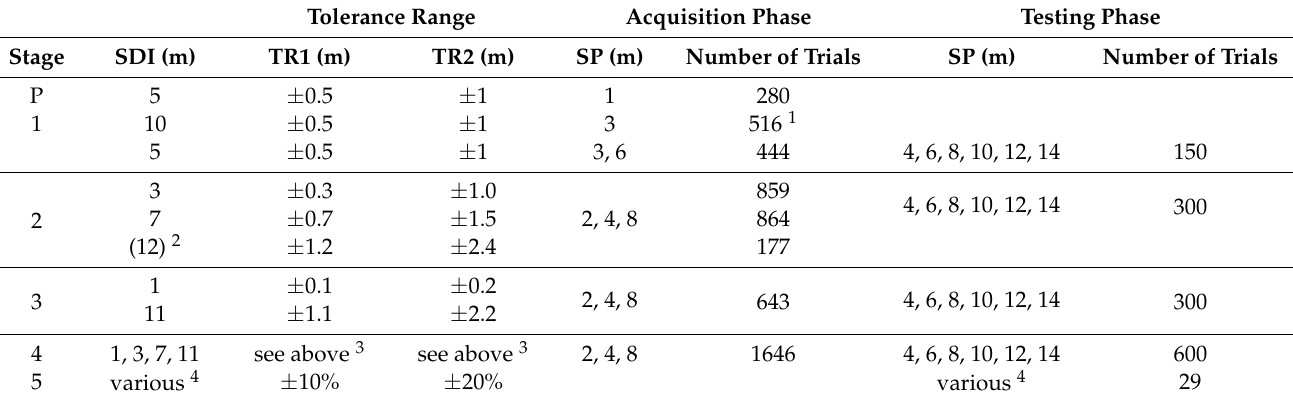
Table 1. Overview of the pretraining (P) and the experimental stages 1–5 of experiment 1. Indicated are the distances presented in the standard distance interval (SDIs in m) from the respective starting points (SPs in m from the hoop station) and the number of trials conducted during the acquisition phase and during the testing phase, as well as the respective tolerance ranges (TR1 and TR2) for the different